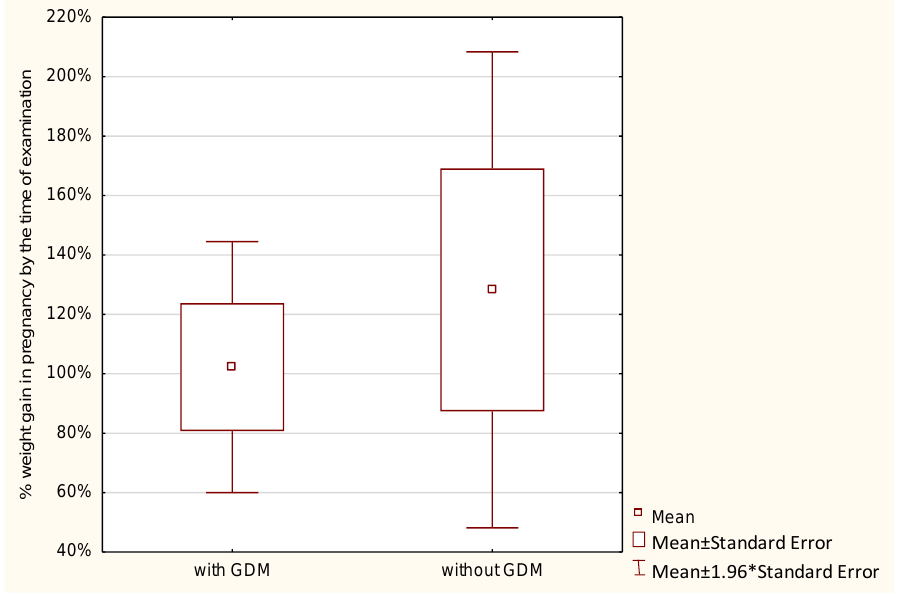
Figure 5. The percentage of GWG by the time of examination performed in pregnant women with a BMI of 25.0 – 29.9.